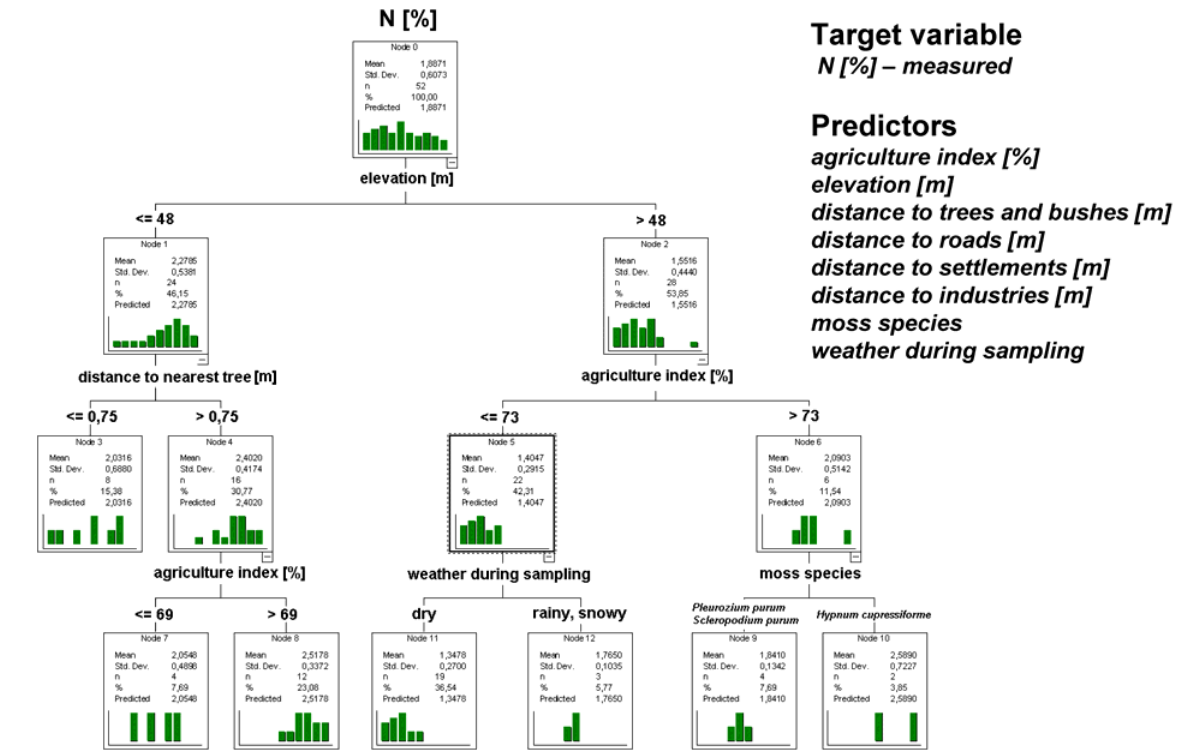
FIGURE 3 . Site-specific variation of N accumulations in mosses from the ERN and WER, 2005.